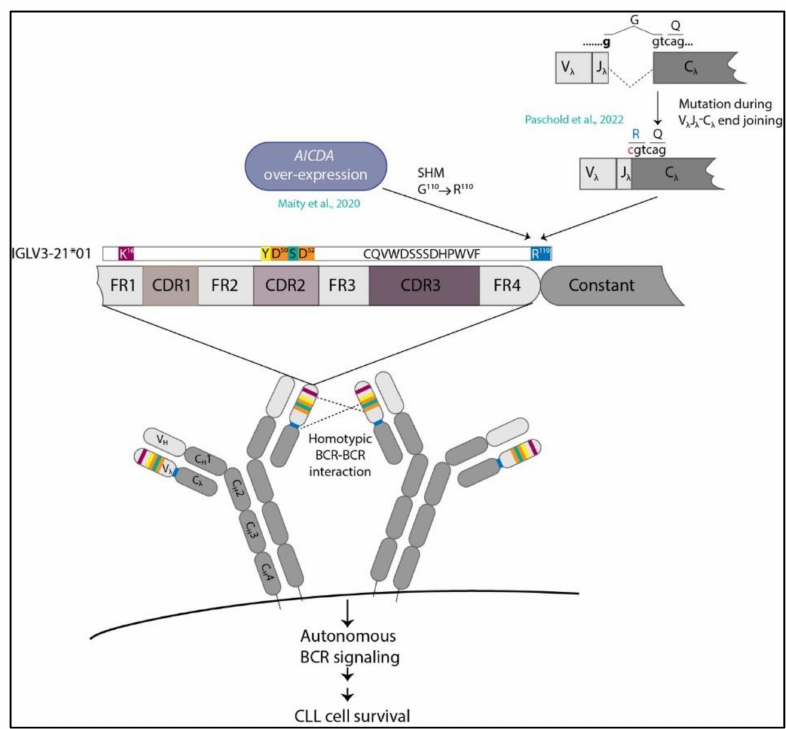
Figure 1. Acquisition of R110G mutation on IGLV3-21*01/04 alleles leads to aggressive CLL. R110G mutation may be acquired through SHM induced by AID overexpression [51] or through defective VL–CL end joining during light-chain gene recombination [74]. The IGLV3-21*01